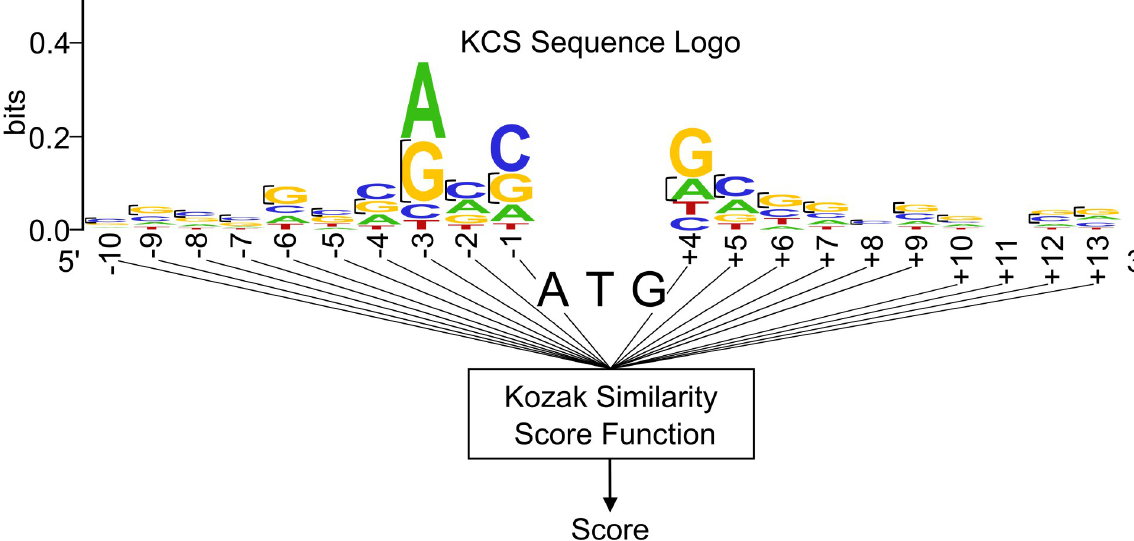
Fig 1. Schematic of the Kozak similarity score algorithm. Based on the sequences flanking an input codon, the algorithm references the KCS Sequence Logo to assign the codon a score.